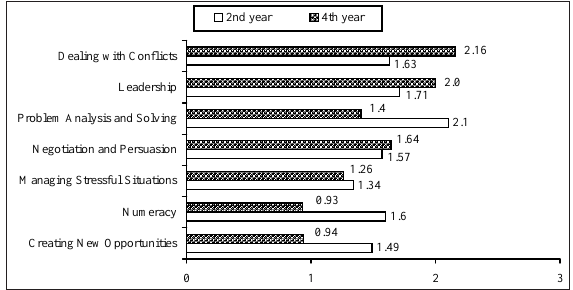
Fig. 6. Evaluation of enterprise competencies acquired during the studies at LAPE (7 least appreciated competencies)